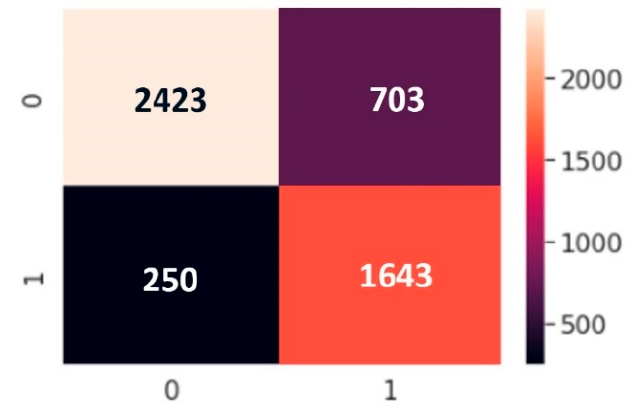
Figure 11. Confusion matrix of ANN model.